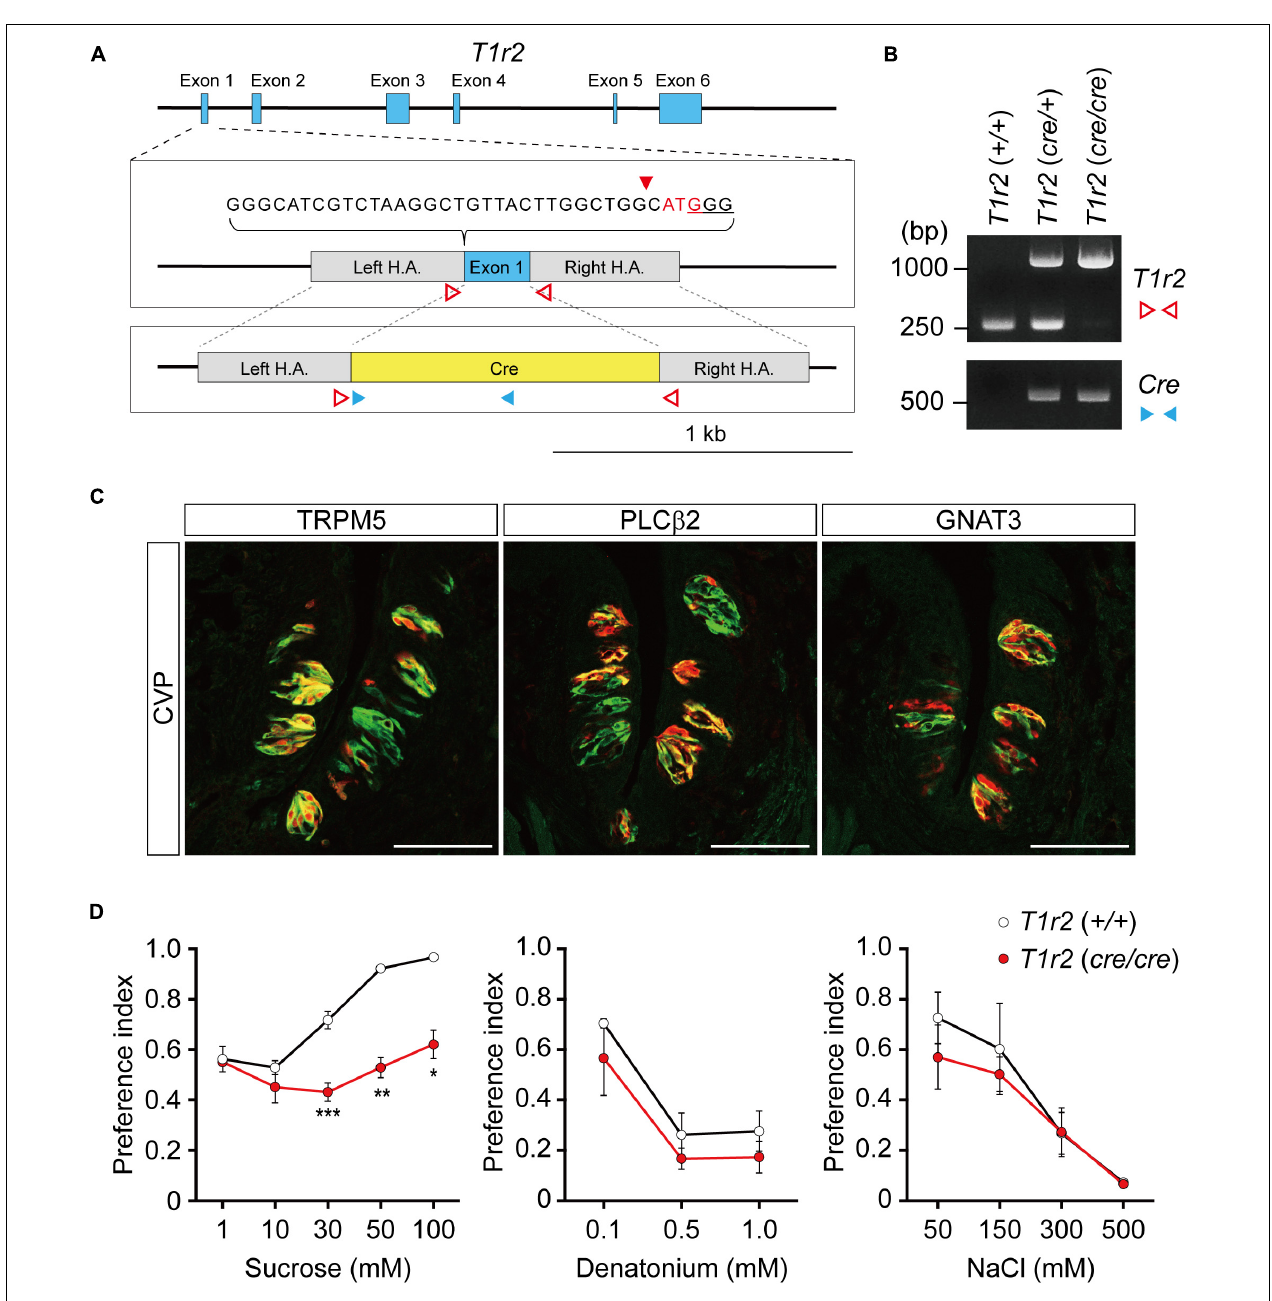
FIGURE 1 | T1r2-Cre mouse strain generation and transgene expression analysis. (A) T1r2 locus schematic and the targeting constructs for T1R2-Cre . The genomic DNA sequences of the gRNA target are indicated. The PAM sequence used for the gRNA is underlined and the cleavage site is indicated by the red triangle. The T1r2 start codon appears in red, and the blue boxes indicate T1r2 exons. The colored triangles indicate the primers used for genomic DNA PCR: T1r2 (red blank); Cre (blue). (B) Confirmation of precise genome editing with genomic DNA PCR analysis using the primer pairs indicated in panel (A) . The predicted amplicon sizes are 261 and 1,030 bp for the wild-type and mutant alleles of T1r2 , respectively, and 584 bp for the Cre transgene. (C) Co-localization of tdTomato with type II taste cell markers in circumvallate papillae (CVP). (D) Confirmation of the T1r2 knock-out phenotype using two bottle tests. Data are presented as means ± S.E.M. Two-sample t -tests were performed for statistical analysis. n = 5 (wild-type) and 3 (knock-out), respectively. * P < 0.05, ** P < 0.01, and *** P <